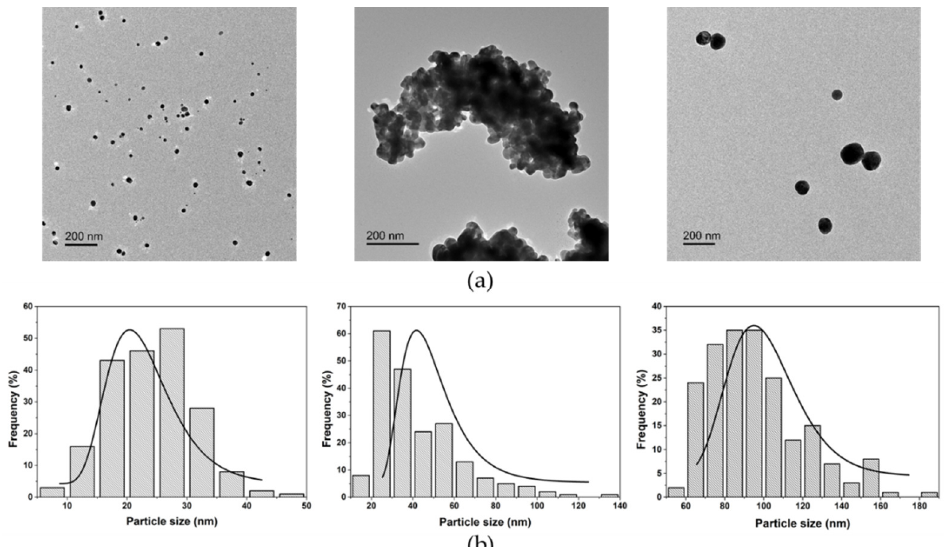
Figure 1. ( a ) TEM images show morphology and particles dispersion. Particles of 15 (PVP-Ag15nm NPs), 50–80 (PVP- Ag50–80nm NPs), and 100 nm (PVP-Ag100nm NPs) are shown. Scale bar of 200 nm. ( b ) Particle size distribution, estimated by measuring an average of 200 particles, and Gaussian fitting are represented by histograms and continuous line, respec- tively.